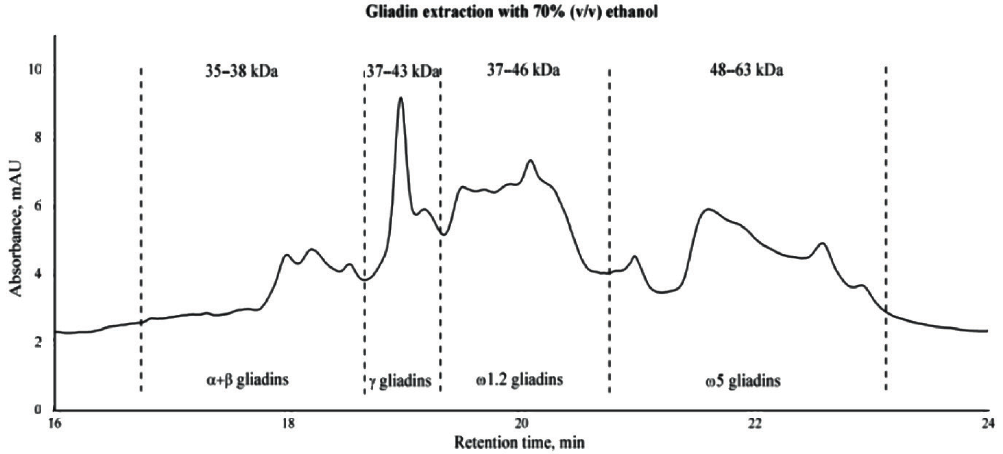
Figure 3 Electrophoregram of gliadin proteins extracted from wheat flour using 70% (v/v) ethanol and separated by capillary gel electrophoresis at a capillary temperature of 25°C and at a voltage of –16.5